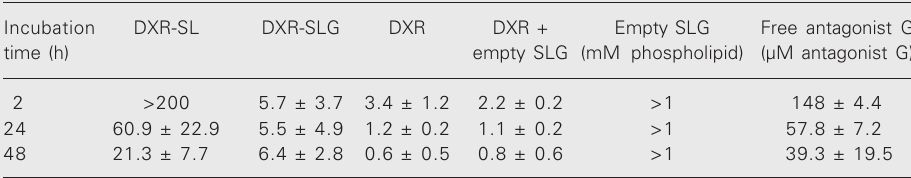
Table 1. Cytotoxicity of various doxorubicin formulations against H82 cells.